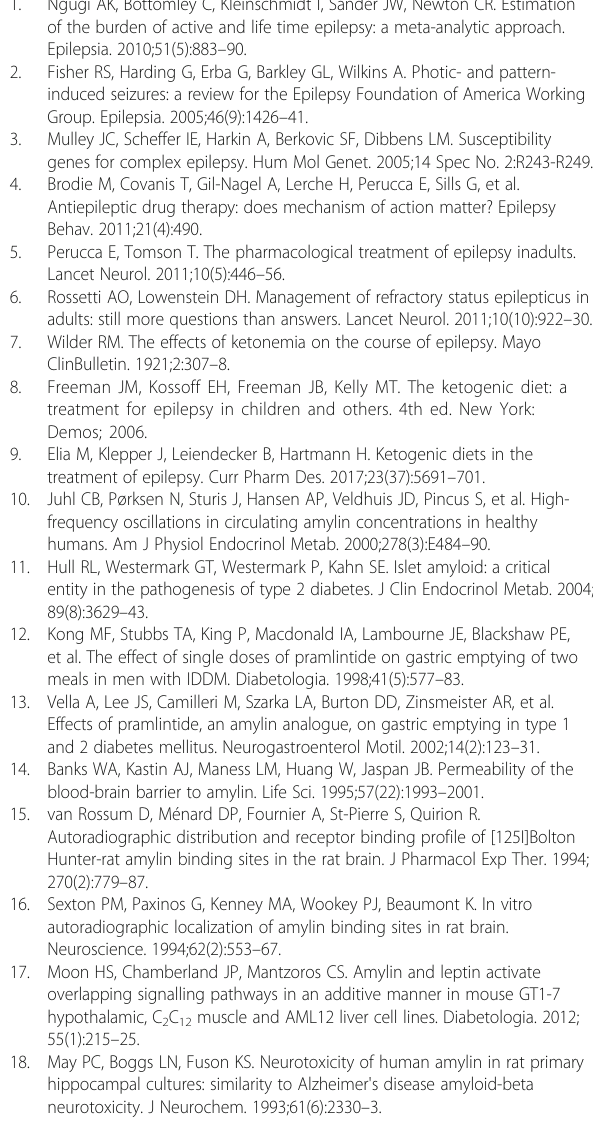
Table 2 Association between serum amylin levels and gender among epileptic patients and controls Epilepsy group (number of men = 20; number of women =